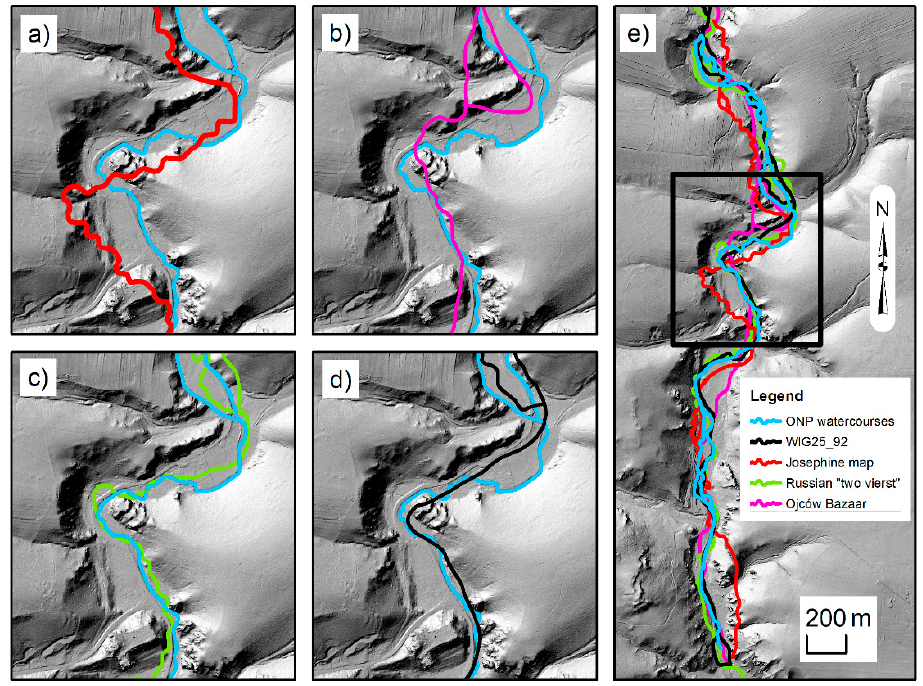
Figure 13. Vectorisation of the ONP watercourse and: ( a ) Josephine map of Galicia; ( b ) Ojców Bazaar; ( c ) Russian “two-verst” map; ( d ) WIG25k; ( e ) all vectors.